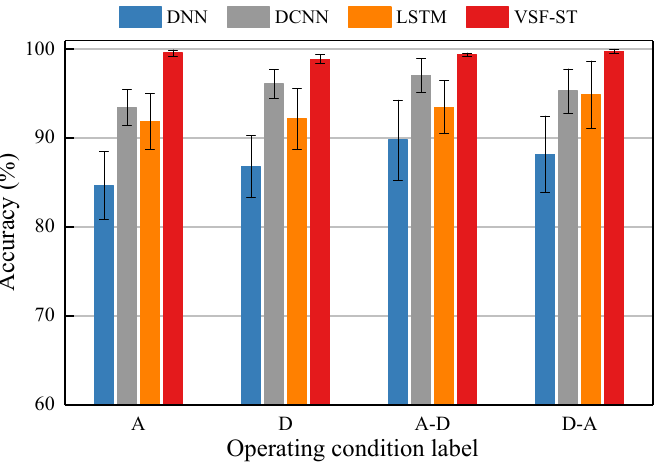
Figure 12. Comparison experiments based on the University of Ottawa